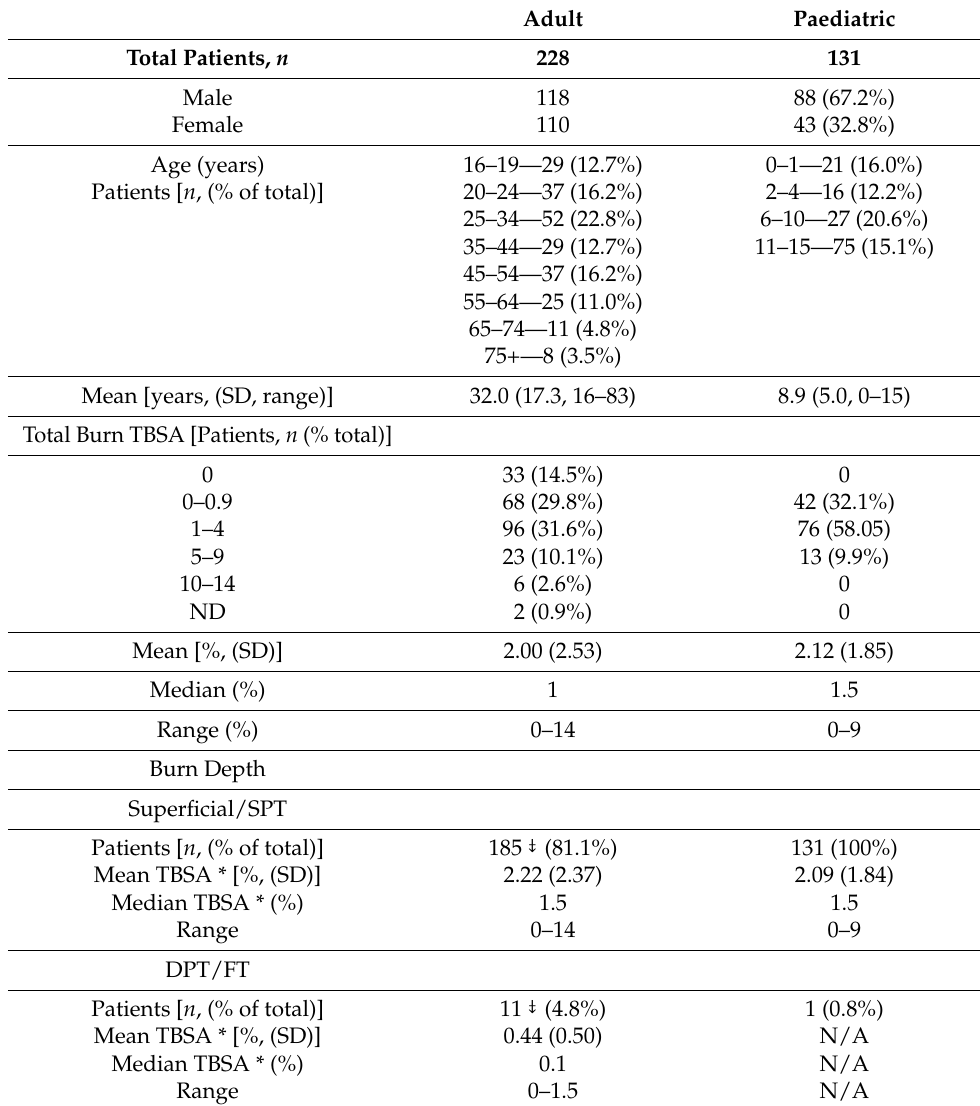
Table 1. Demographics and characteristics of all sunburn injuries presenting to the combined Man- chester Burns Services 2010–2019 (incl.). ND—not documented, TBSA—total body surface area, SPT—superficial partial thickness, DPT—deep partial thickness, FT—full thickness. * mean/median calculated from patients with documented burn of greater than 0% for a given depth. ⤈ some pa- tients had no documented depth of burn, hence were not included in analysis by depth.